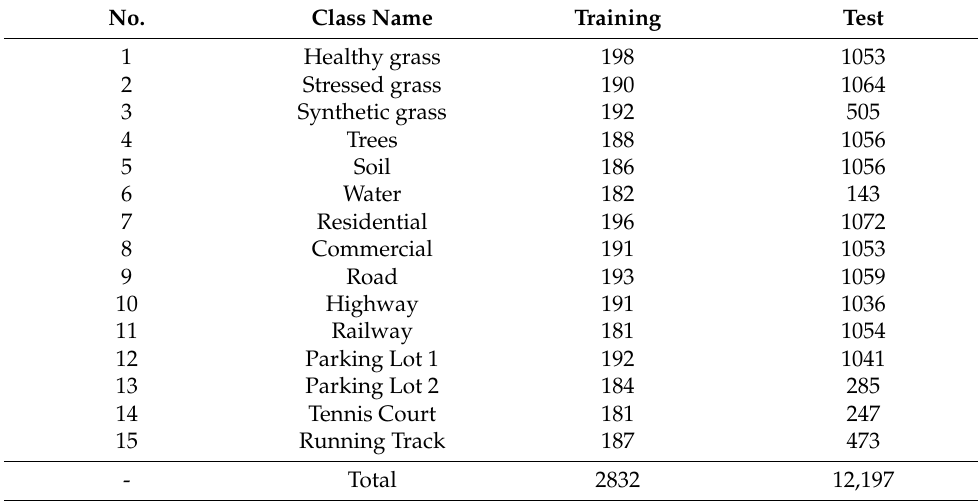
Table 2. List of the number of training and test samples for each class in Houston datasets.